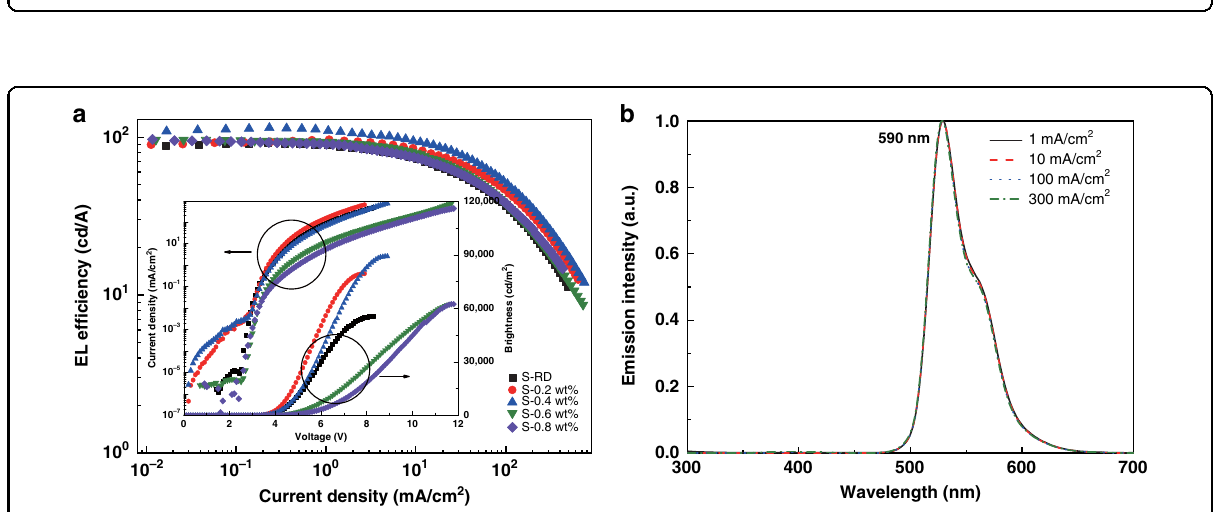
Fig. 11 The EL pro fi les of PQ 2 Ir(dpm) based devices. a Current density – Voltage ( J – V ) characteristics of the electron-only devices. Inset: Comparison diagram of the relative recombination zones. b Normalized PL spectra of Tb-11 fi lm, 26DCzPPy fi lm, 4 wt% PQ 2 Ir(dpm) doped 26DCzPPy fi lm, 0.4 wt% Tb-11 co-doped 26DCzPPy fi lm, as well as 0.2 wt% Gd-1 co-doped 26DCzPPy fi lm. Insert: Schematic representation of energy transfer processes. Reprinted from [88], with the permission of Royal Society of Chemistry